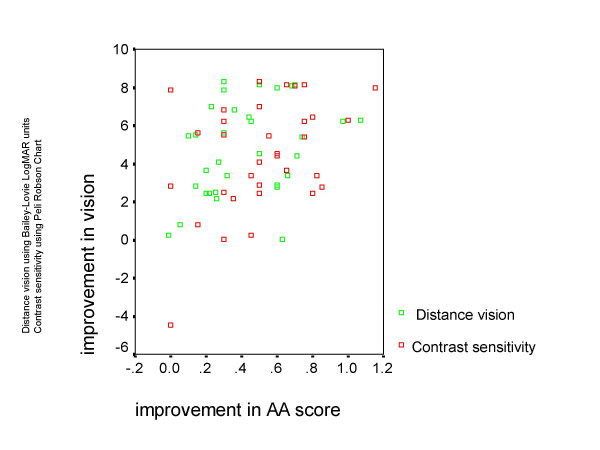
Improvement in contrast sensitivity and distance vision after capsulotomy v improvement in AA scores after capsulotomy